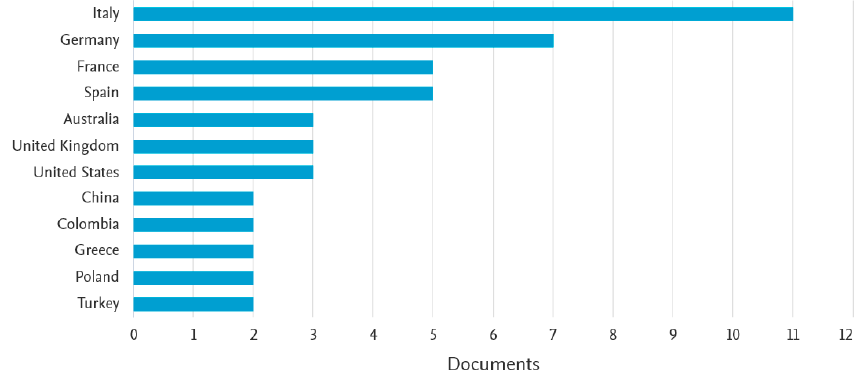
Figure 5. Distribution of papers by countries (top 12 countries).